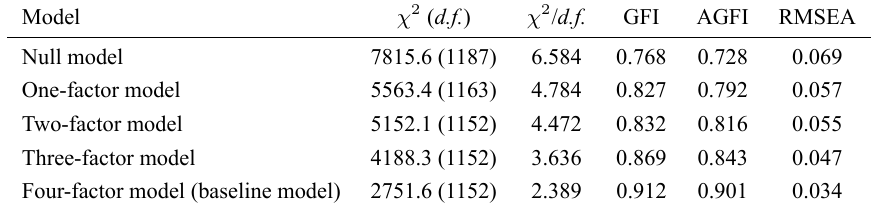
Table 1. Confirmatory factor analysis: discriminate validity.